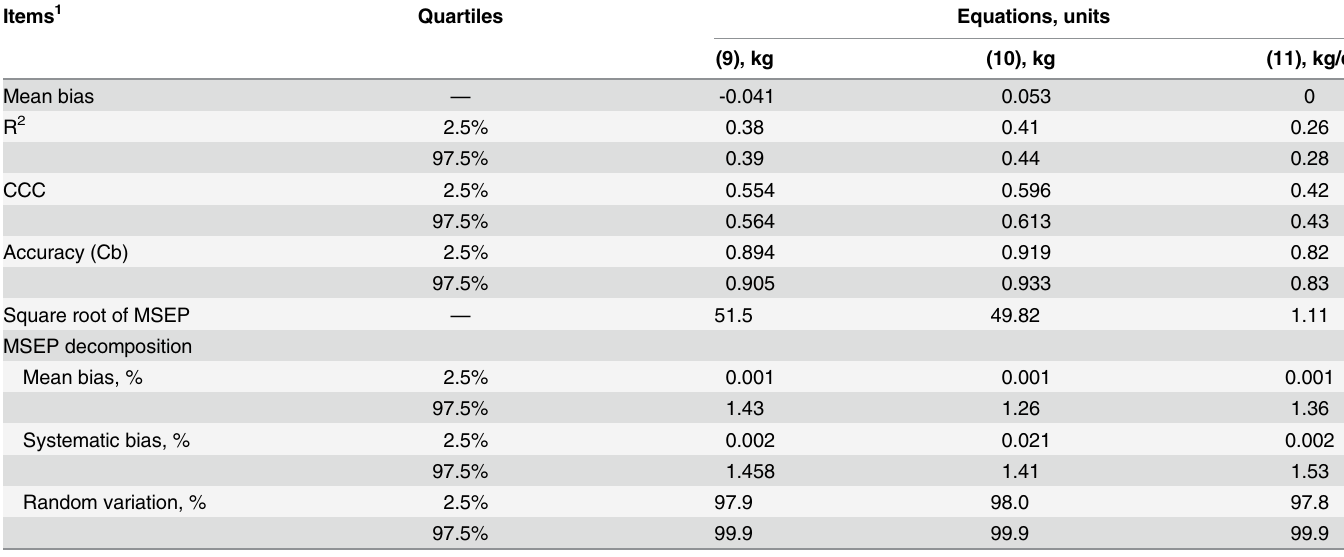
Table 3. Adequacy statistics from the cross-validation simulations (n = 1,000) for selected equations. Items